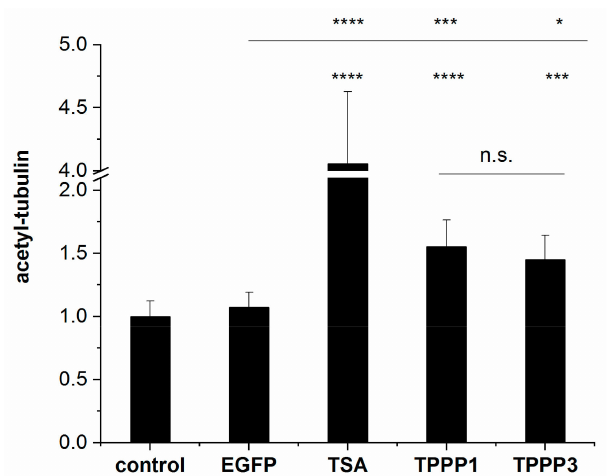
Figure 6. Quantification of the acetylation-promoting effects of TPPP proteins on the microtubule network in living human cells by cELISA assay. HeLa cells were transfected with pEGFP-TPPP3 or pEGFP-TPPP1 or treated with the tubulin deacetylase inhibitor TSA, as described in the Materials and Methods Section. The EGFP and the acetyl-tubulin levels were detected by specific antibodies. The values for medium (in absence of cells) were subtracted in all cases. The acetyl-tubulin levels are presented as the mean ± SD. Statistical comparisons were performed with one-way ANOVA followed by Tukey’s test, as compared to the control or as the lines indicate (* p < 0.05, *** p < 0.001 and **** p < 0.0001). n.s.: not